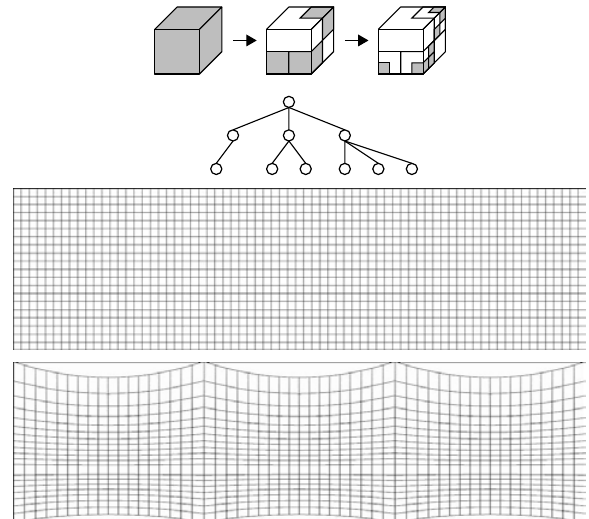
Figure 5: Top: Spatial subdivisions of an octree up to level 3. Occupied leaf nodes are shaded gray. The corresponding tree structure of the sparse data structure. Middle: Panorama image in eqirectangular prjection. Bottom: Panorama image composed of 3 Pannini projections as used in Fig.